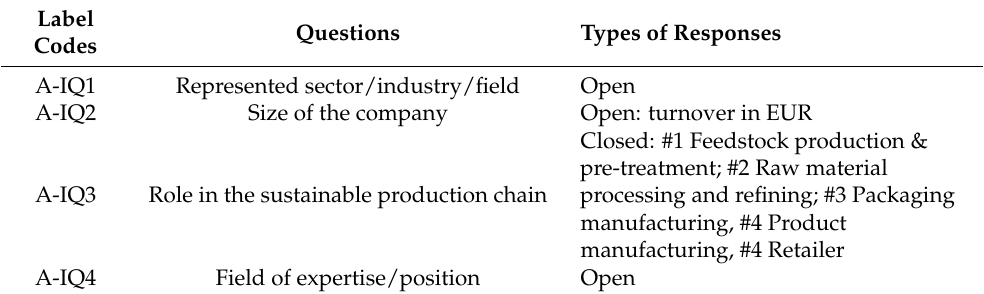
Table 2. The structure of the questions of interviews—Part: A—Interviewee Profile.